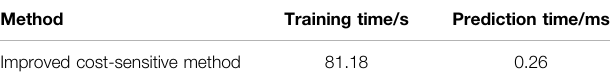
TABLE 3 | Simulation time of the proposed